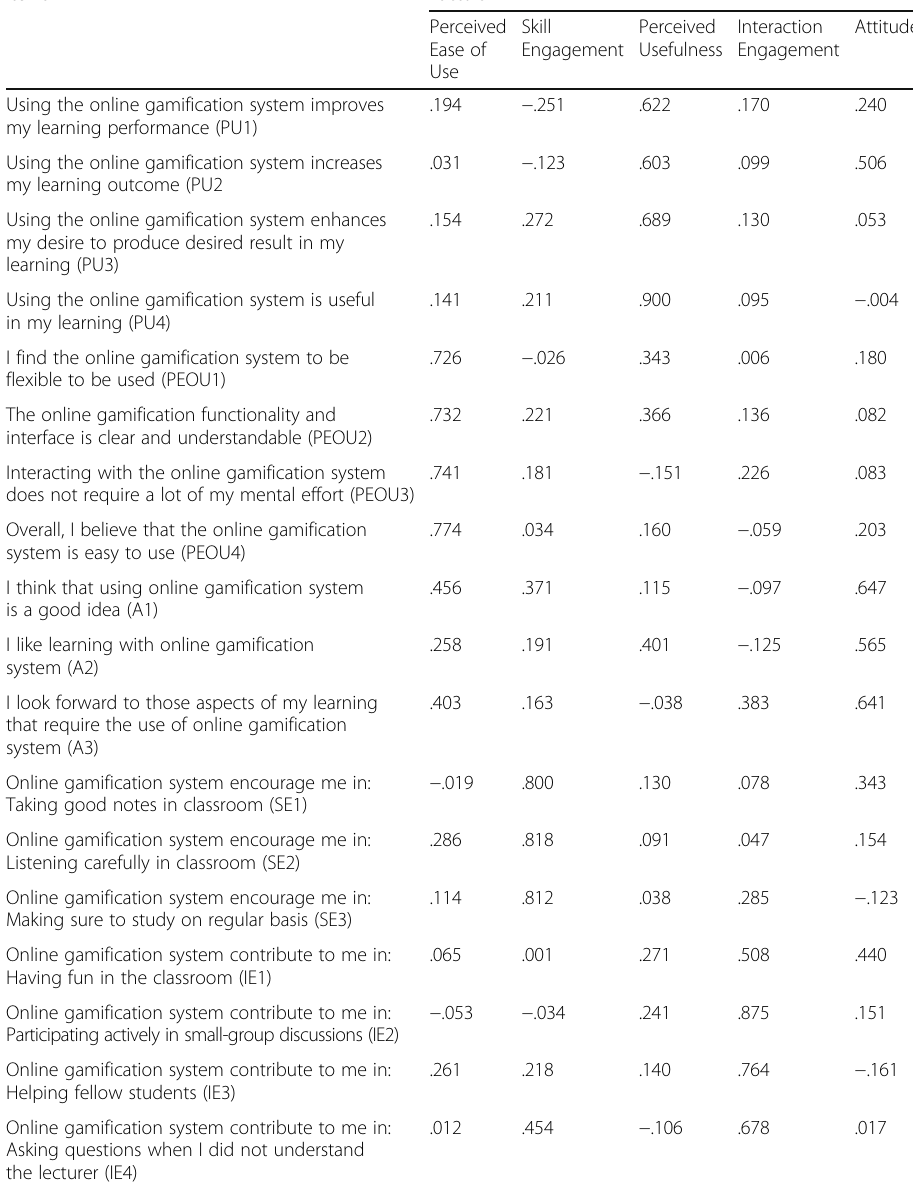
Table 6 Exploratory factor analysis of measurement scales